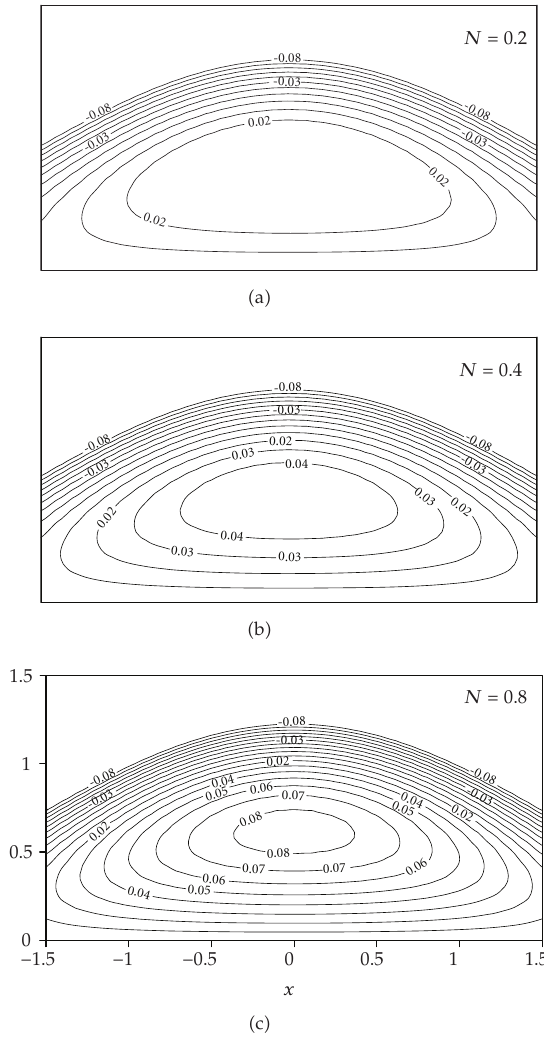
Figure 15: Stream lines for di ff erent values of N